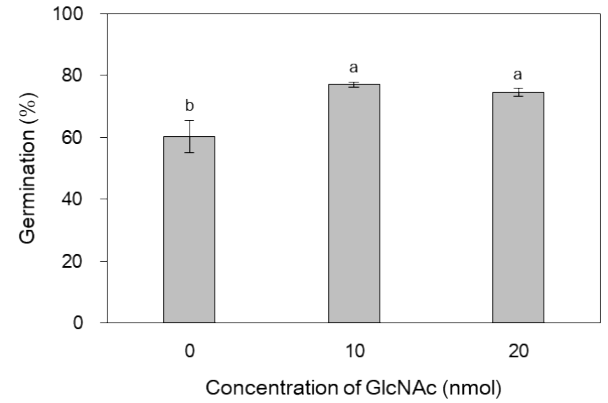
Fig. 5: Effect of GlcNAc on in vitro germination of kiwifruit pollen. Pollen was incubated in germination medium supplemented with varying amounts (0, 10, or 20 nmol) of GlcNAc. Different letters on the error bars indicate significant differences based on Tukey’s Studentized range at p ≤ 0.05. Error bars represent SE of mean val- ues ( n =